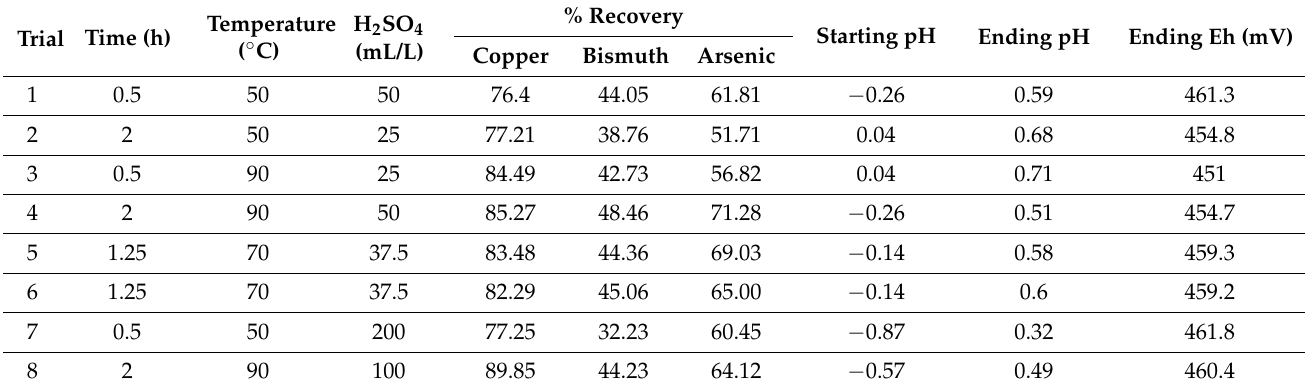
Table 9. Elemental recoveries (%) to leachates of sulfuric acid trials, pH data, and Eh data.